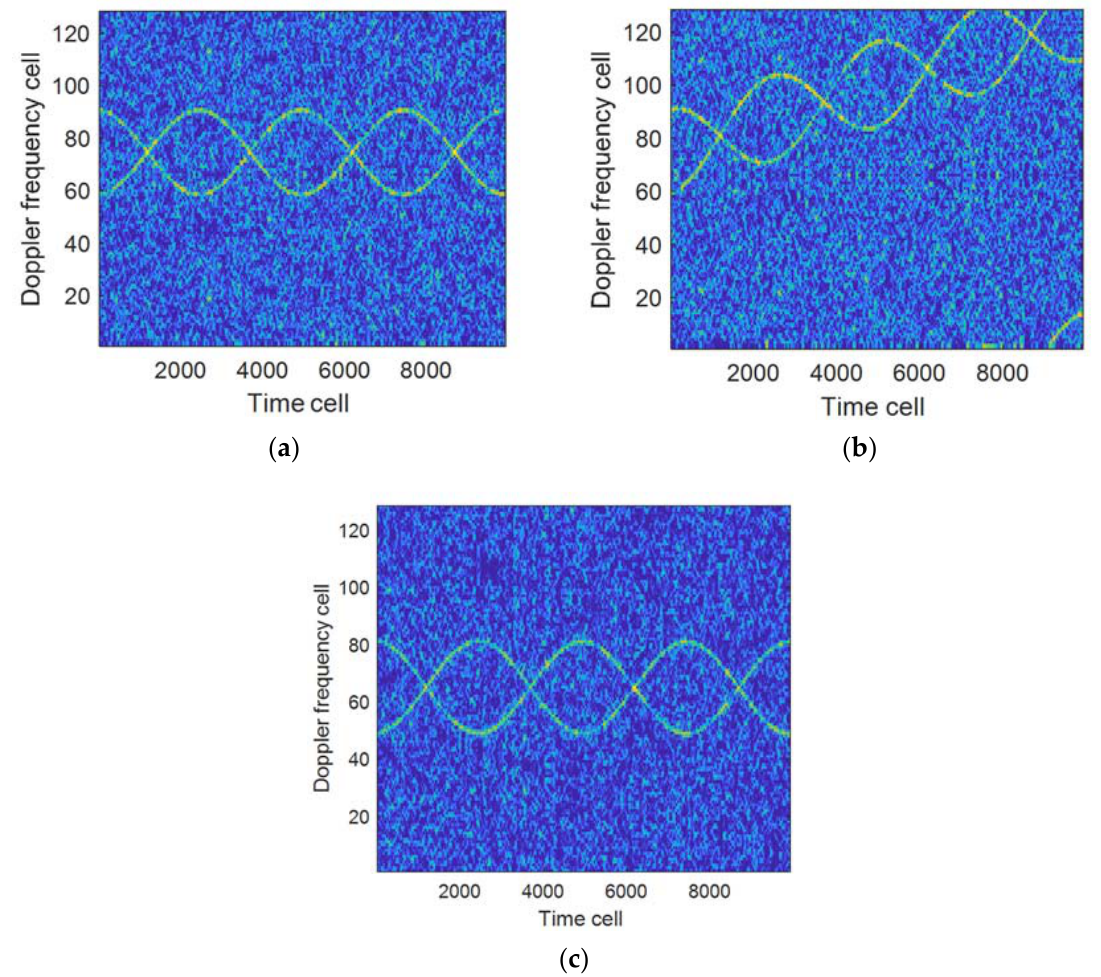
Figure 2. The influence of velocity and acceleration on the time-frequency curve. ( a ) ˆ v 0 = 20 m/s, a = 0 m/s 2 ; ( b ) ˆ v 0 = 20 m/s, a = 60 m/s 2 ; ( c ) Results when compensated ( ˆ v 0 = 19.6 m/s, a = 60.4 m/s 2 ).